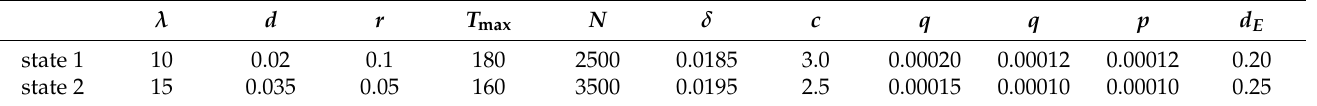
Table 2. The values of the main parameters of model